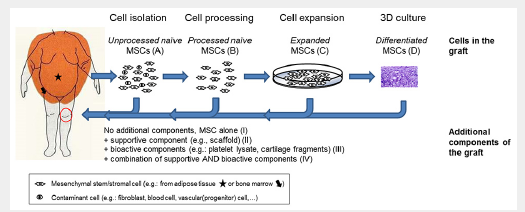
Classification of mesenchymal stromal/stem cell (MSC)-based strategies based on the type and differentiation stage of cells (capital letters in parenthesis) and additional components (Roman numbers in parenthesis) present in the graft. Below are listed examples of MSC-based graft material used in selected clinical trials registered at http://clinicaltrials.gov (keywords used for the research: stem cells AND cartilage repair). A–II: bone marrow MSC aspirate in a scaffold (identifier NCT00885729). B–III: MSCs isolated from adipose tissue specimens (liposuction) combined with platelet-rich plasma (identifier NCT01739504). B–IV: concentrated bone marrow-derived cells on a collagen scaffold, covered with a platelet gel (identifier NCT02005861); MSCs separated from redundant joint tissues (bone marrow or synovium) combined with cartilage fragments in a fibrin gel (identifier